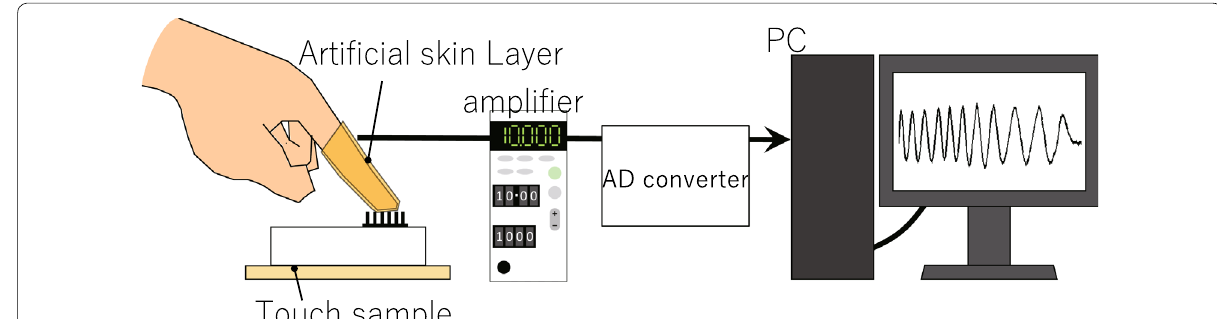
Fig. 5 Sensor system. The sensor signal is uploaded into a personal computer (PC) via a strain gauge amplifier and an analog/digital (AD) converter